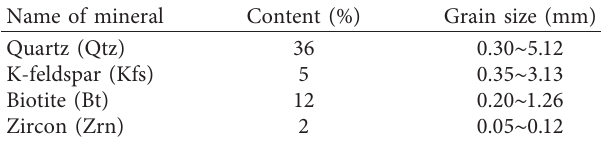
Figure 1: Rock core and granite specimens. Table 1: Mineral content and grain size of granite